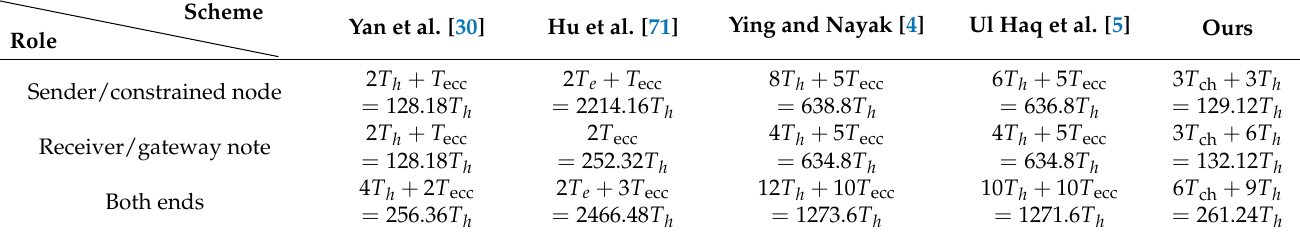
Table 5. Computational complexity